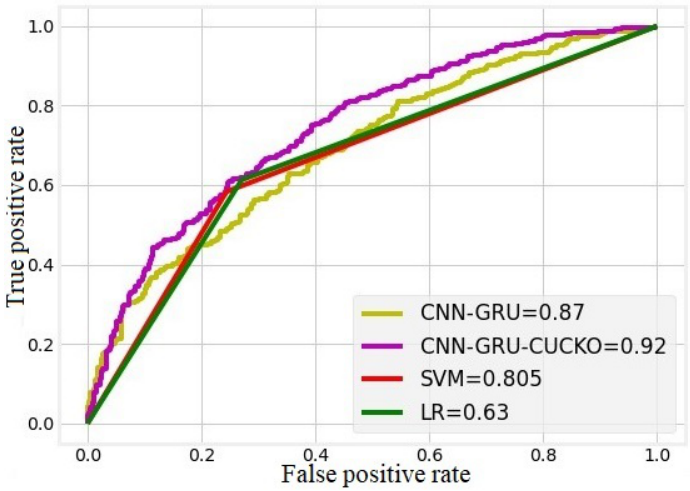
Figure 11. ROC curve of proposed and existing methods.